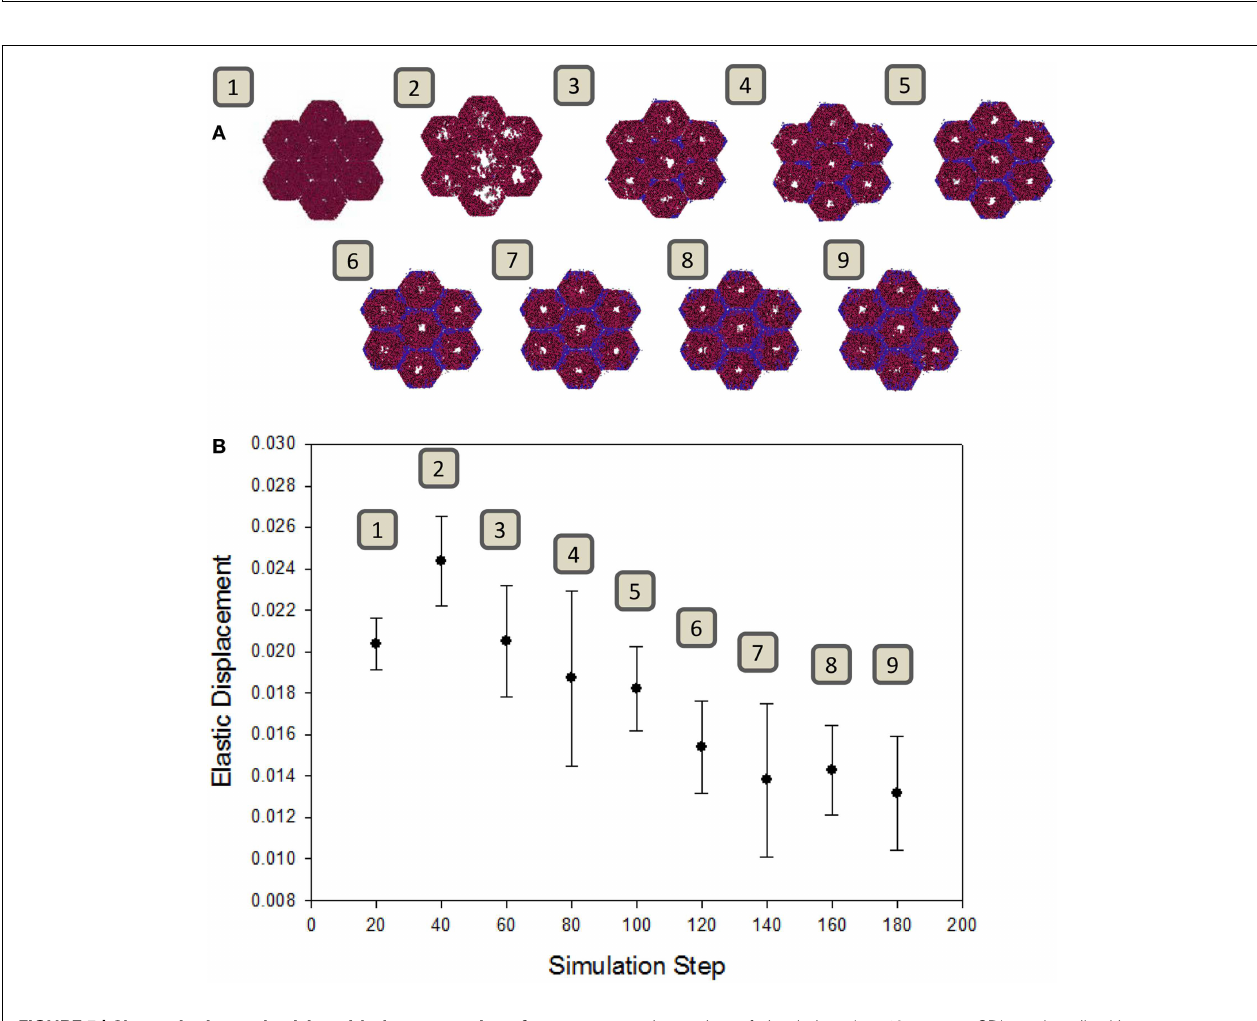
FIGURE 5 | Change in tissue elasticity with the progression of fibrosis . (A) Snapshots of the model at intervals of 20 simulation time steps. (B) Elastic displacement measured at each of the same